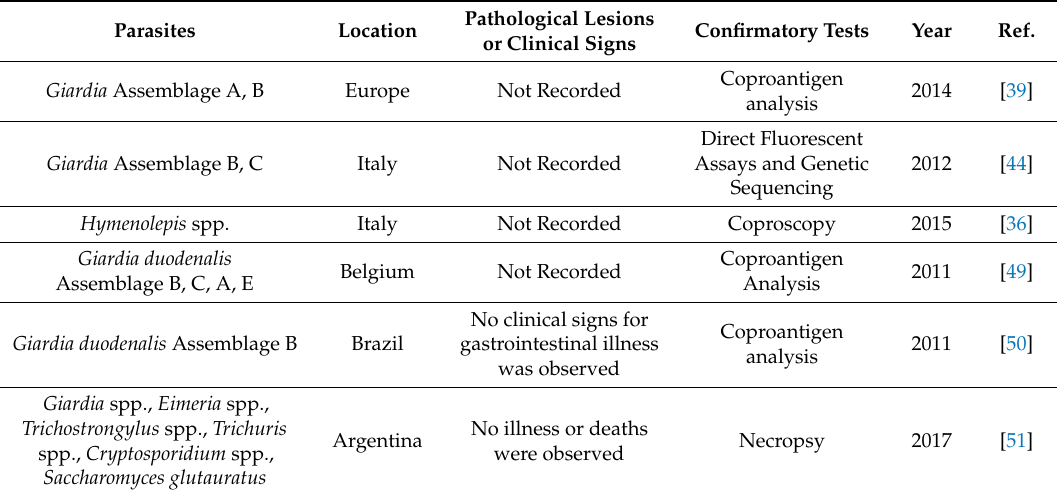
Table 4. Gastrointestinal Parasites present in Chinchillas and its effect on the